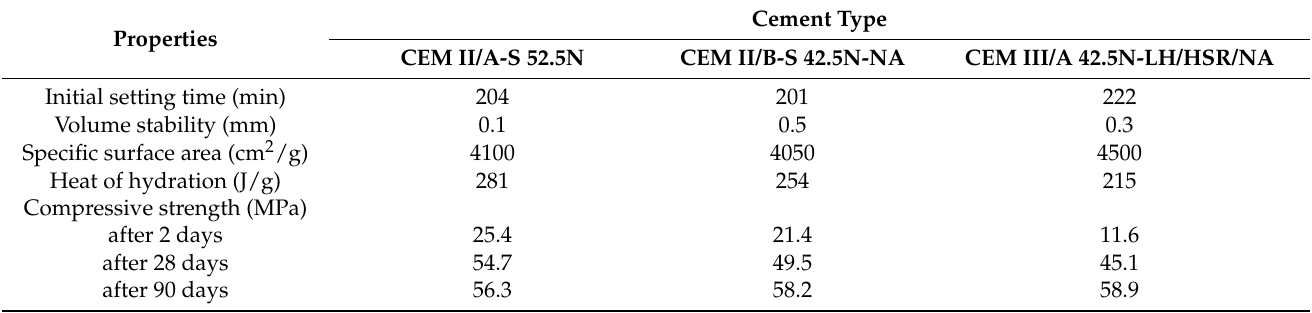
Table 3. Properties of the slag